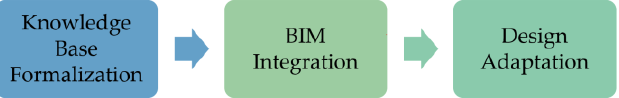
Figure 3. Milestones for the Knowledge-driven Design Decision Support.